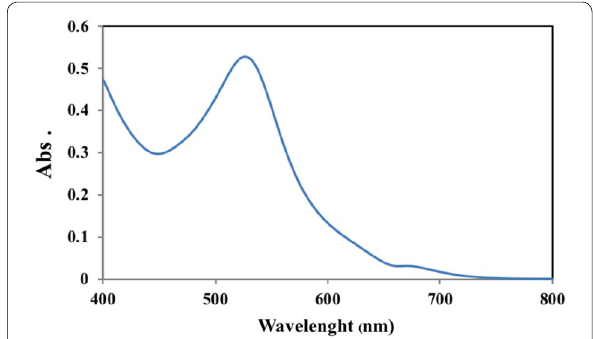
Fig. 6 UV–Visible absorption spectrum of TiO 2